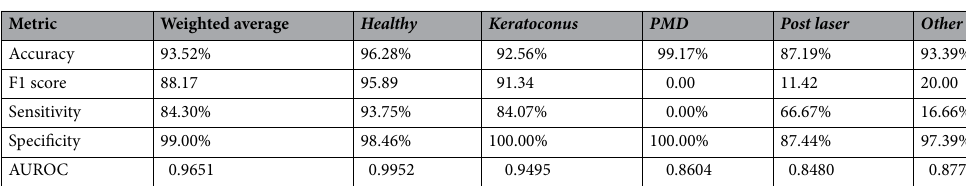
Table 4. Evaluation results of the final model on the test cornea scans dataset. Because the dataset is highly imbalanced, the average is weighted taking into account the support of each class. For the classes n/a and keratoglobus there are no samples in the test dataset, so they are